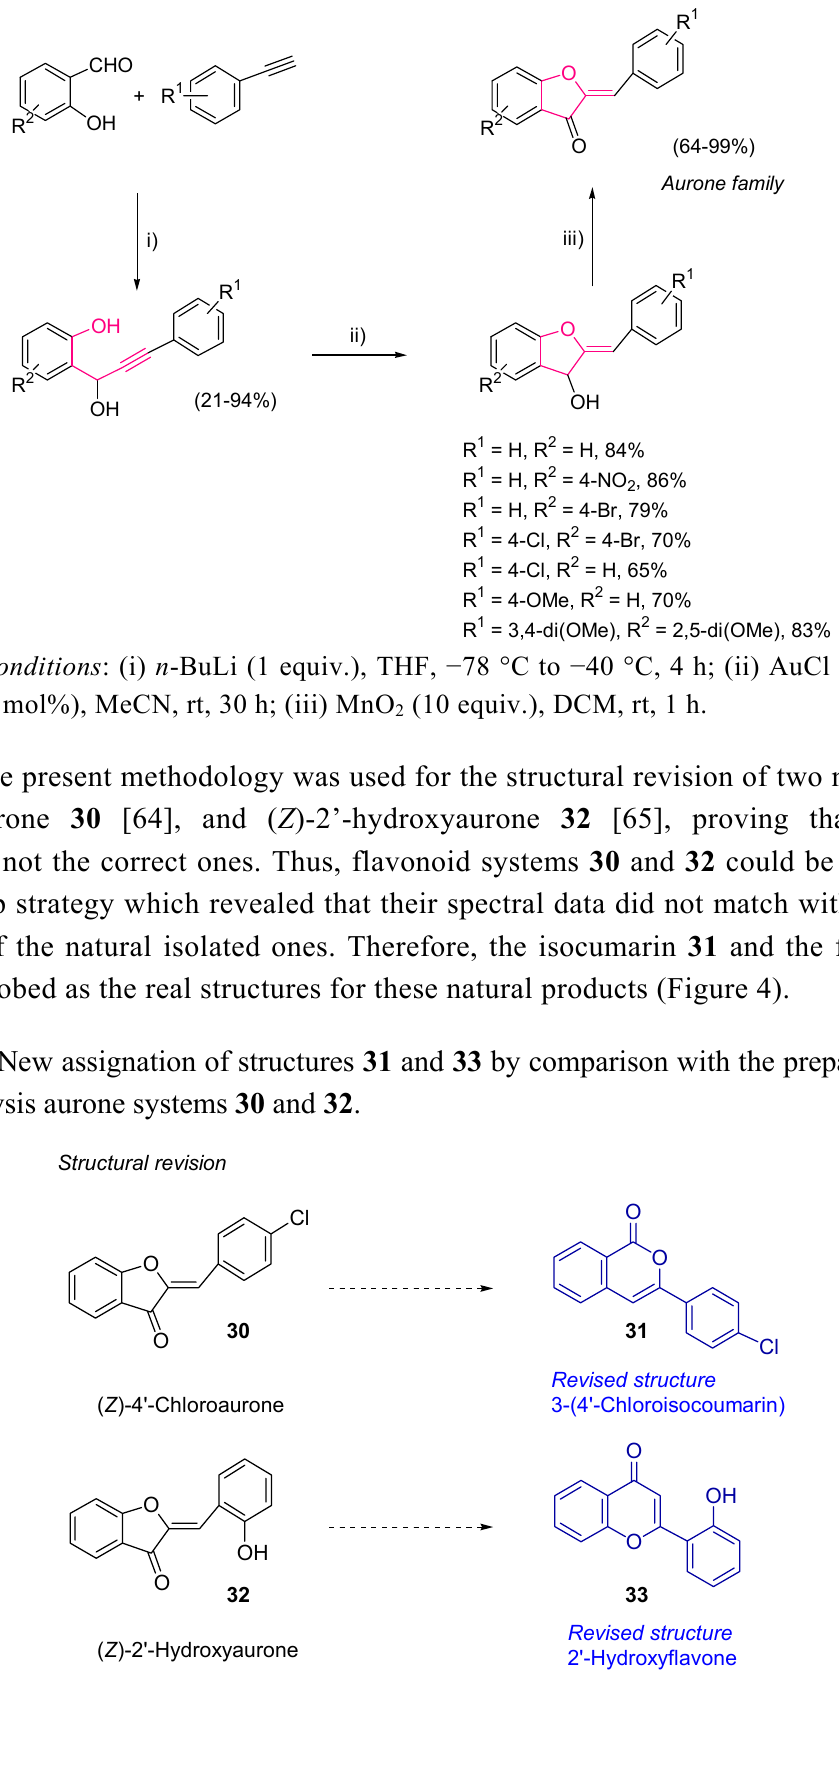
Scheme 11. Synthesis of aurone skeleton by gold-catalyzed cycloisomerization.